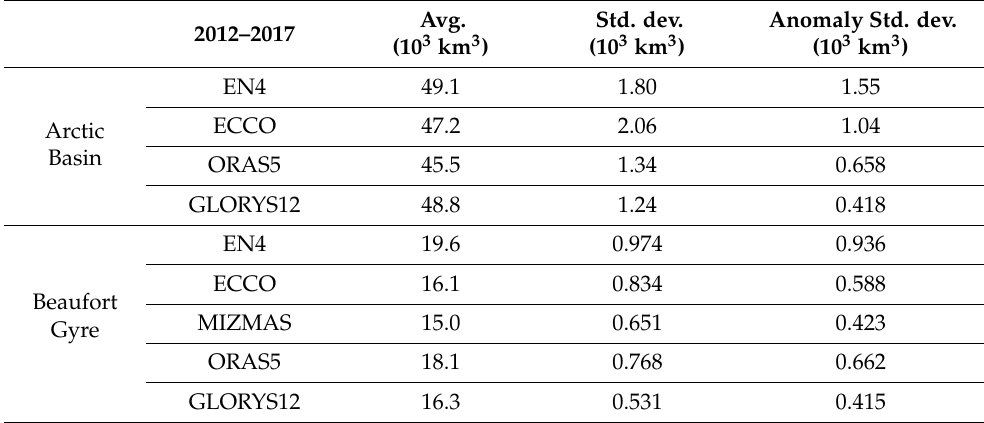
Table 5. Statistical analysis of averages (avg.) and standard deviations for FWC in the Arctic Basin and the Beaufort Gyre are depicted in Figure